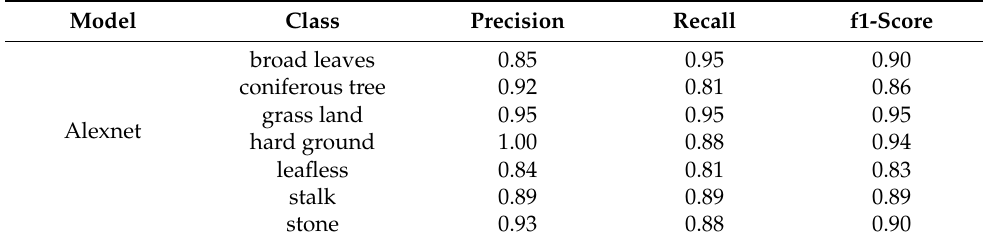
Figure A1. Architecture of the four tested models: ( a ) AlexNet, ( b ) VGG19, ( c ) ResNet50, ( d ) ResNet152 and ( e ) residual structure: the bottleneck in ( c ) and ( d ). In addition to the typical structures of convolutional layers, pooling layers, and fully connected layers, AlexNet also adds Rectified Linear Unit (ReLU) [79] layers and dropout [80] layers. These new structures are one of the reasons why the performance of AlexNet is more prominent than the performance of previous convolutional neural networks. VGG19 replaces the large convolution kernel with a smaller convolution kernel based on AlexNet, which further improves the performance. ResNet50 and ResNet152 go a step further. They use a stacked residual network structure to make the model deeper so that this type of network can obtain improvements without performance degradation. Table A1. Metrics of various models.